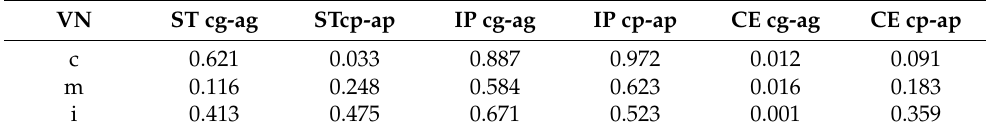
Table 9. The paired t -Test test ( α = 0.05)- p values for microhardnessamong control glazed-aged glazed, respectively control polished-aged polished groups in each area. VN ST cg-ag STcp-ap IP